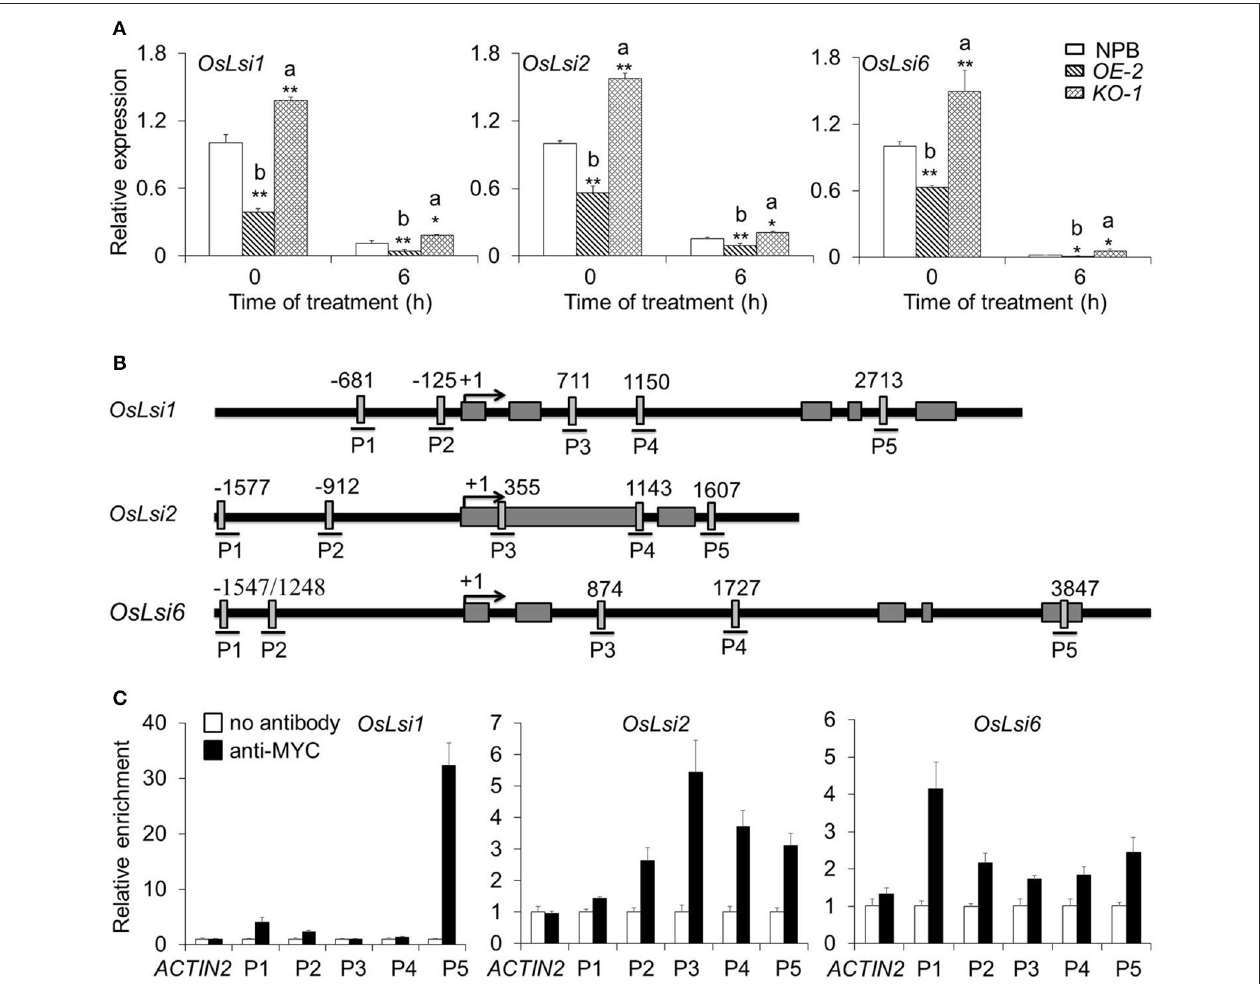
FIGURE 7 | OsARM1 directly interacts with OsLsi1 , OsLsi2 , and OsLsi6 in rice. (A) Expression of As transporter genes in wild-type NPB, OsARM1-KO , and OsARM1-OE . Total RNA was extracted from the roots and shoots of 2-week-old seedlings (wild-type NPB, OE-2 , and KO-1 ) treated with Kimura B nutrient solution containing 50 µ M As(III) for 0 and 6h. The expression levels of OsLsi1 , OsLsi2 , and OsLsi6 in roots were examined by qRT-PCR analyses. OsGAPDH was used as a reference gene. The experiment was repeated three times with similar results. Asterisks indicate significant differences from wild type (* P < 0.05; ** P < 0.01 by Student’s t -test). “a” and “b” indicate values that are significantly higher or lower, respectively, in OE-2 or KO-1 than in wild type. (B) Schematic diagram of the potential AC-I element (ACC(A/T)A(A/C)) in the promoter and genomic sequences of OsLsi1 , OsLsi2 , and OsLsi6 . Lines under the boxes indicate sequences detected by ChIP-qPCR assays. Numbers indicate the nucleotide positions relative to the corresponding translational start site (ATG), which is shown as + 1. (C) ChIP-qPCR analyses showing the in vivo interaction between OsARM1 and the predicted AC-I element in the promoters of OsLsi1 , OsLsi2 , and OsLsi6 . Protein/DNA complexes isolated from the root of OsARM1-OE ( OE-2 ) transgenic rice were immunoprecipitated with or without the anti-Myc antibody, respectively. For each promoter, various DNA fragments were used to determine the enrichment of the DNA fragment containing the AC-I element. A promoter fragment of OsACTIN1 was used as a negative control. The experiment was repeated three times with similar